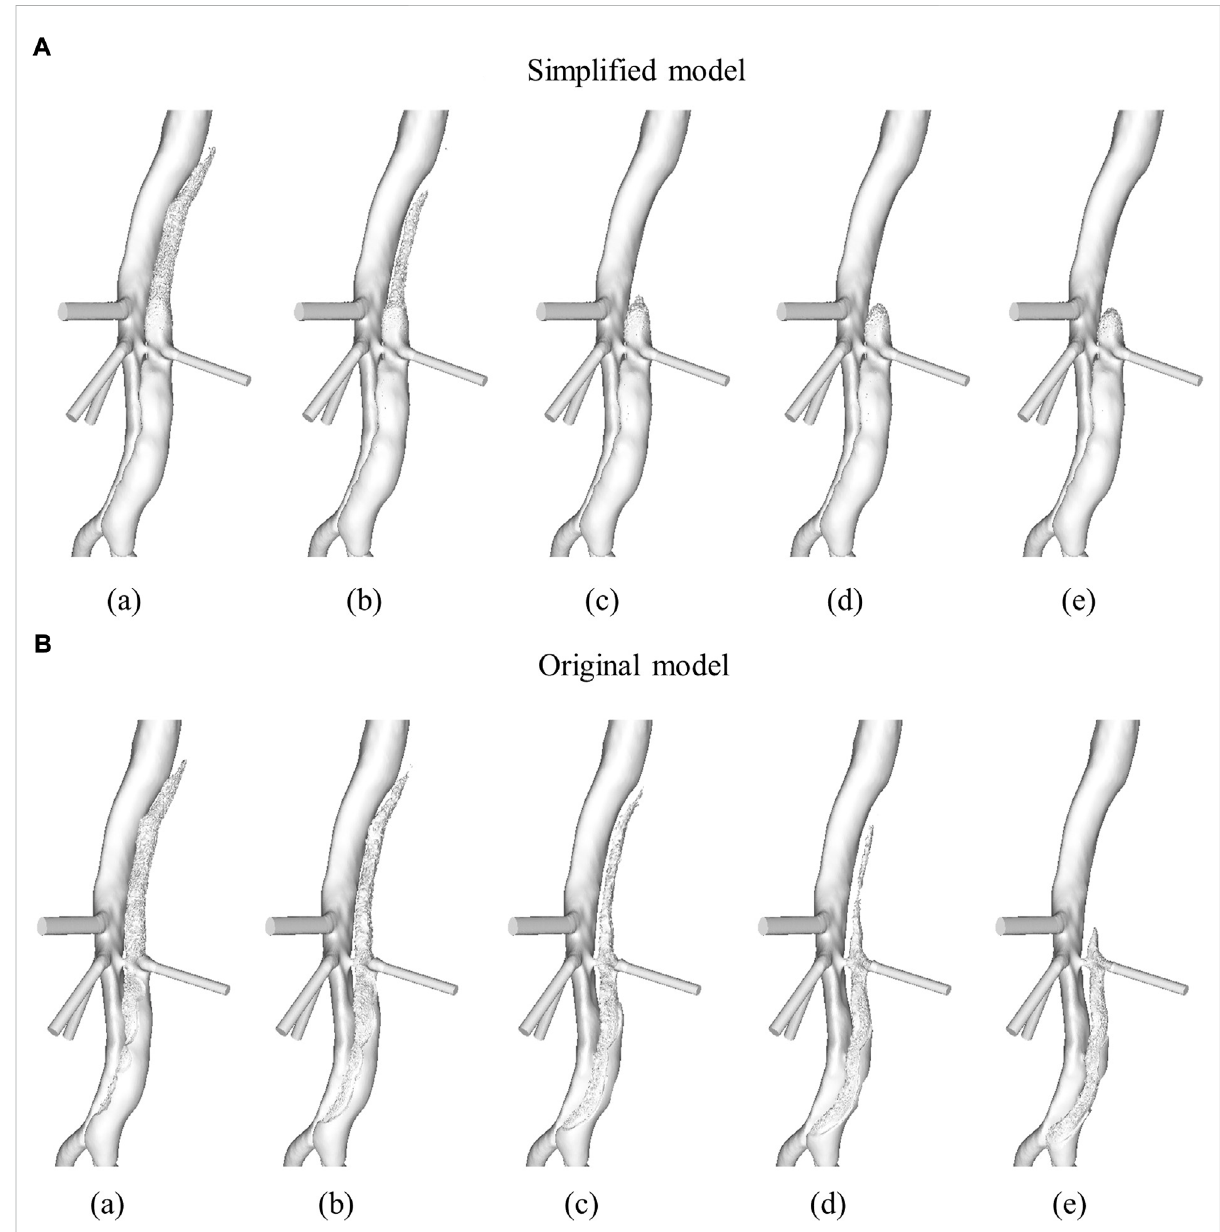
FIGURE 5 Evolution of the descending aorta false lumen surface due to thrombus formation in (A) simpli fi ed model and (B) original model. Time points presented are after (a) 6, (b) 9, (c) 12, (d) 15, and (e) 20 cardiac cycles. Figure adapted from Armour et al. (2020b).